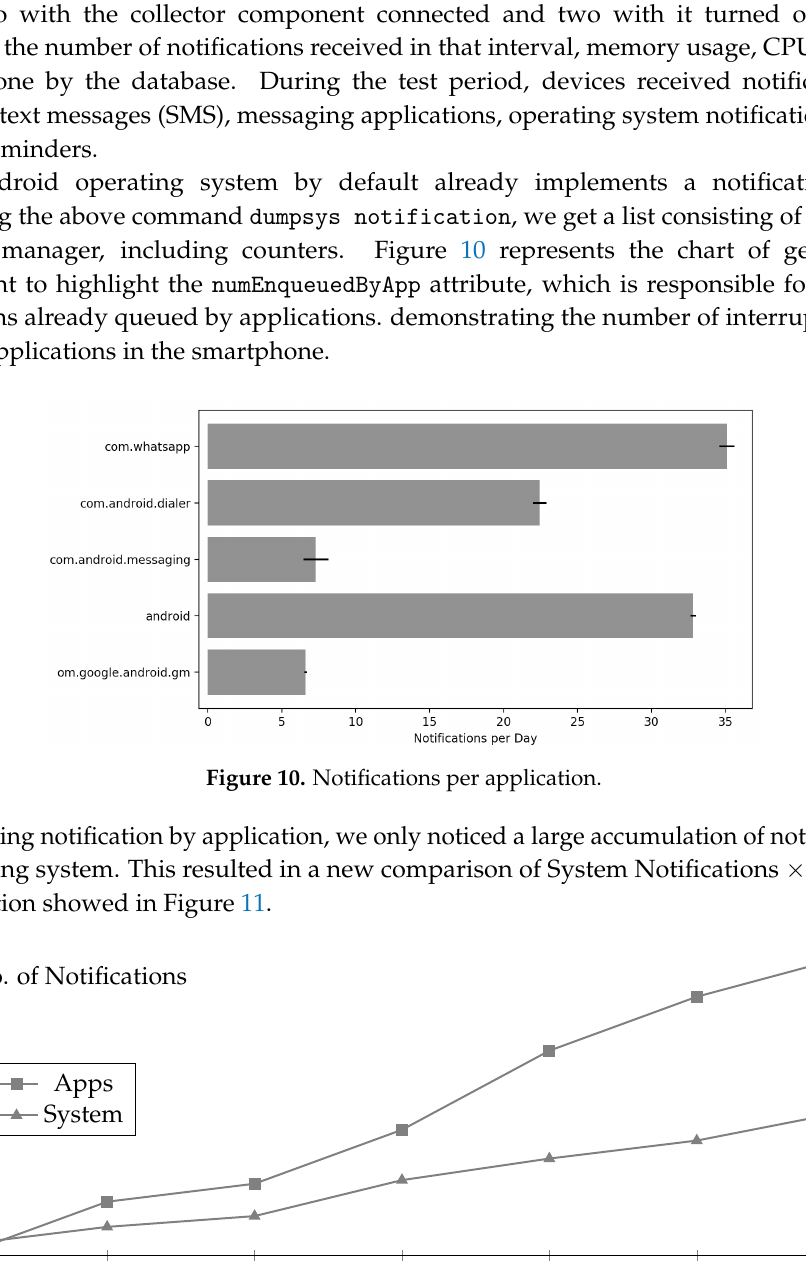
Figure 10 represents the chart of generated files.